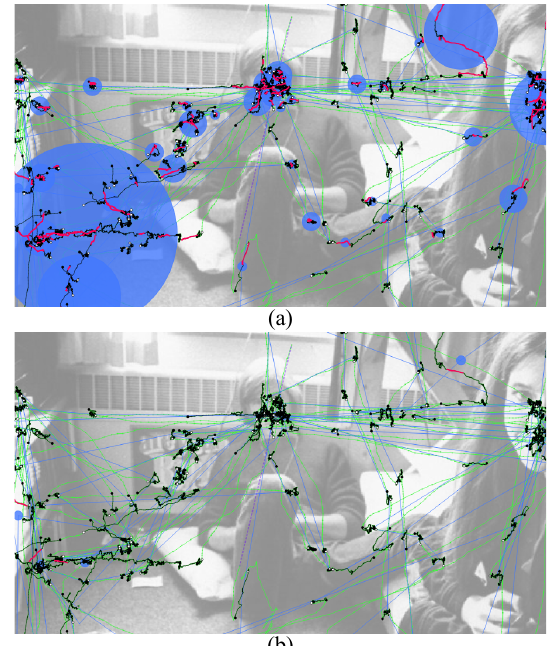
Figure 9 . (a) Result of the microsaccade filter when changing all parameter values in such a way that more microsaccades can be detected using values in the range as given in Table 1 and (b) when using parameter values to limit the detection. A trial from the photo data set is